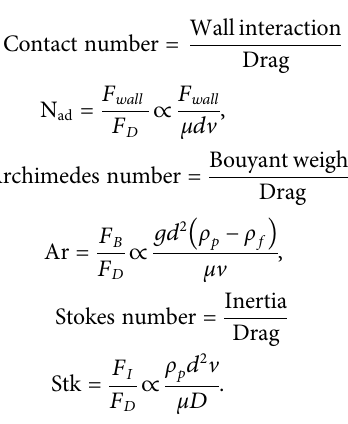
Frontiers in Mechanical Engineering |